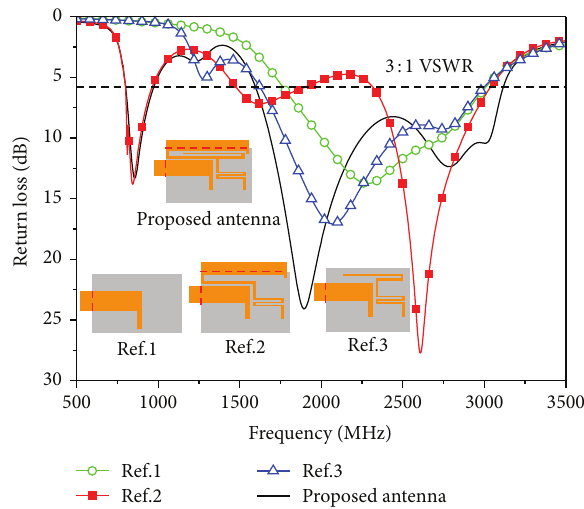
Figure 2: Comparison between the simulated return loss of the proposed antenna and three antennas for reference with the feeding striponly(Ref.1),withthefeedingstripandtheshortingstripbranch 1 (Ref.2), and with the feeding strip and the shorting strip branch 2